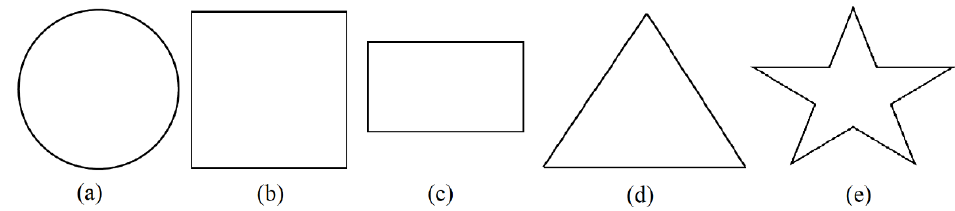
Figure 7. Two-dimensional geometric shapes. ( a ): illustration of a circle (diameter = 10.16 cm). ( b ): illustration of a square (length = 10.16 cm, width = 10.16 cm). ( c ): illustration of a rectangle (length = 10.16 cm, width = 5.08 cm). ( d ): illustration of an equilateral triangle (side = 10.16 cm). ( e ): illustration of a star (height = 10.16 cm).